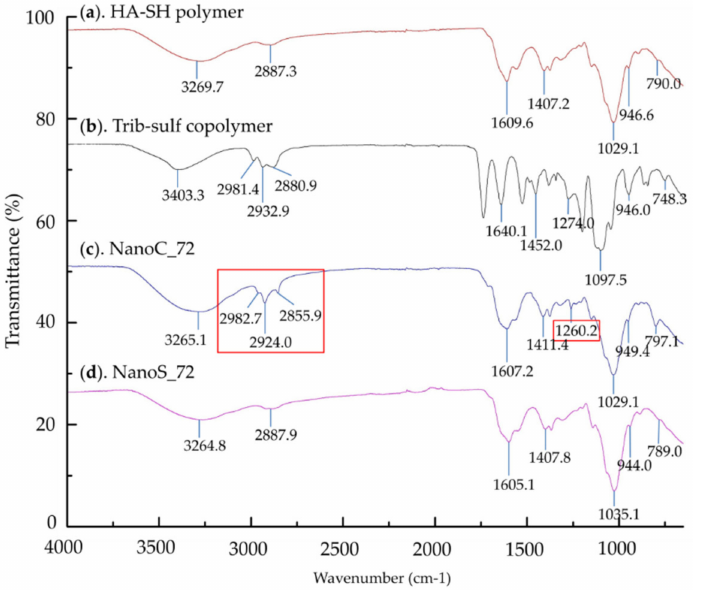
Figure 6. FT-IR spectra of ( a ). HA-SH polymer; ( b ). Trib-sulf copolymer; ( c ). NanoC_72 and ( d ).